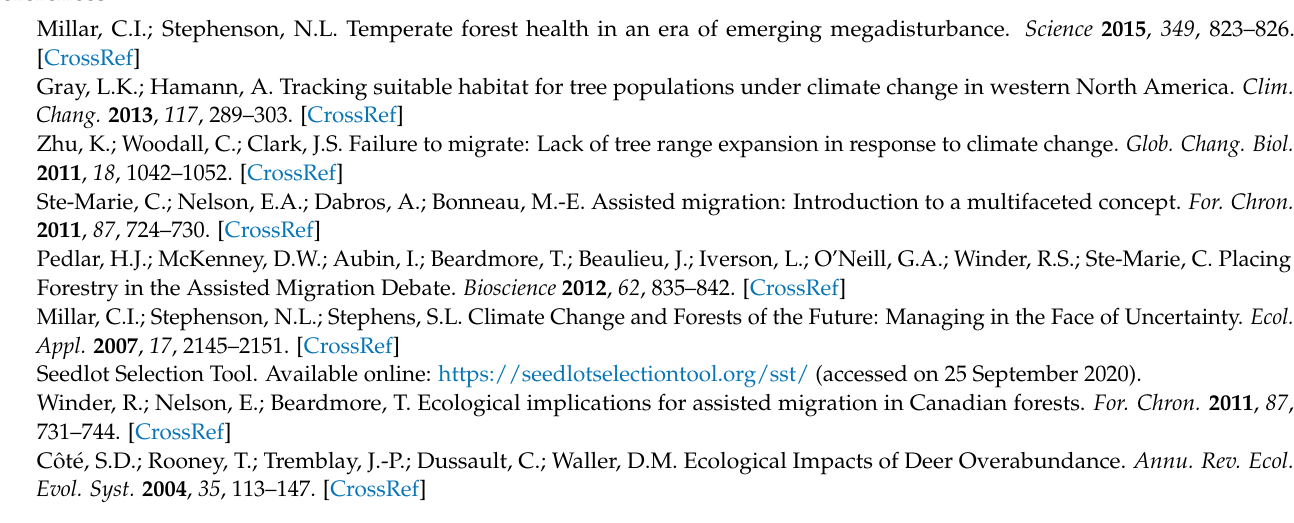
Figure A5. Flavonoid concentration of northern white cedar ( Thuja occidentalis L.) seedlings from three climate analogues after simulated winter browsing. Seedling’s dry mass ( 𝑥̅ ± 95%CI of model estimates) was measured after ten weeks of growth in a greenhouse. Three different climate analogues were used (2018: analogue to the current climate at Réserve faunique de Portneuf (Québec, QC, Canada); 2050: analogue to the climate predicted for mid-century; 2080: analogue to the climate predicted for the end of the century). The analysis was performed using a linear mixed model with a random effect of blocks ( n = 5). Shapes represent the distribution of the data. The interaction between browsing and climate analogue was statistically significant, however, the a posteriori test did not reveal statistically significant difference among groups.